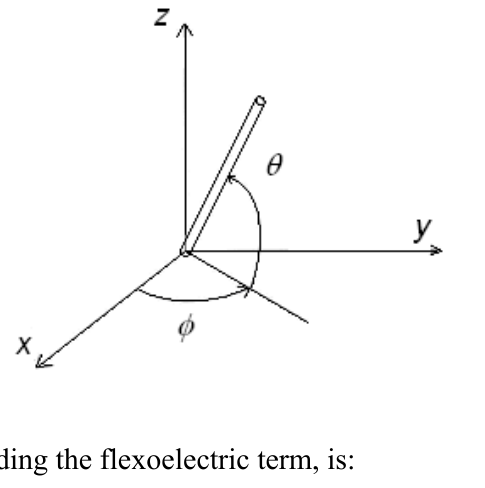
Figure 1. The frame of reference and the angles used to describe the director, represented by the rod-like